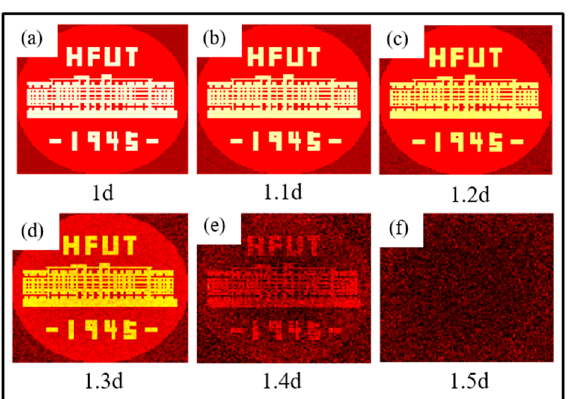
Figure 7. Retrieving results based on PR method for the systems (in 0–2 km) with different particle sizes. ( a ) The standard system with the reference particle size, and the particle sizes are increased by 0.1 times ( b ), 0.2 times ( c ), 0.3 times ( d ), 0.4 times ( e ), 0.5 times ( f ).